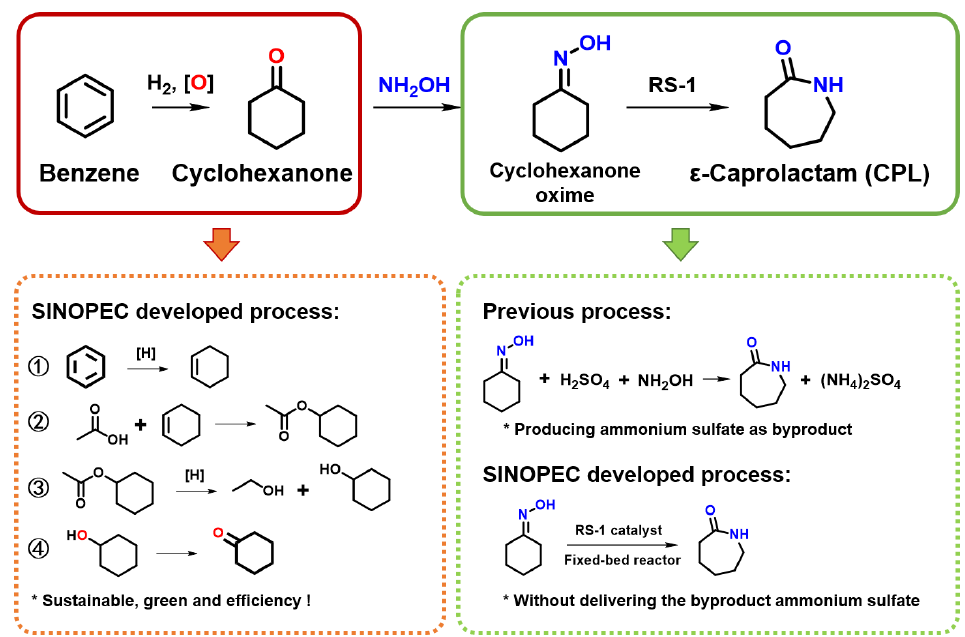
Figure 3. The novel synthesis process of fossil-based CPL developed by SINOPEC. J. Frost first developed a route for the production of CPL from lysine [39]. In this process, lysine first underwent cyclization forming α -amino- ε -caprolactam ( α -ACL) at ca. 190 ◦ C using 1,2-propanediol as the solvent, and then deamination was subsequently car- ried out using a stoichiometric amount of KOH and hydroxylamine-O-sulfonic acid at ca. − 5 ◦ C resulting in 99% molar yields of CPL. In order to explore a more sustainable process, Frost converted lysine monohydrochloride to CPL with a Pt-S/C catalyst [40]. A 15% molar yield of CPL was obtained in a one-step process under H 2 and H 2 S atmospheres. H. Kim et al. invented an advanced two-step strategy to produce CPL [41]. Lysine